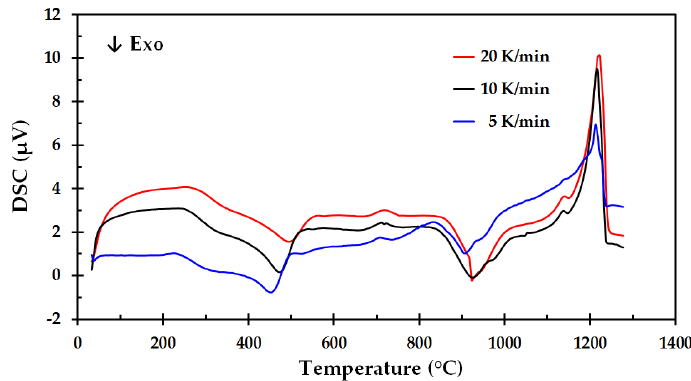
Figure 16. Differential scanning calorimetry (DSC) analysis of the thermal insulation.